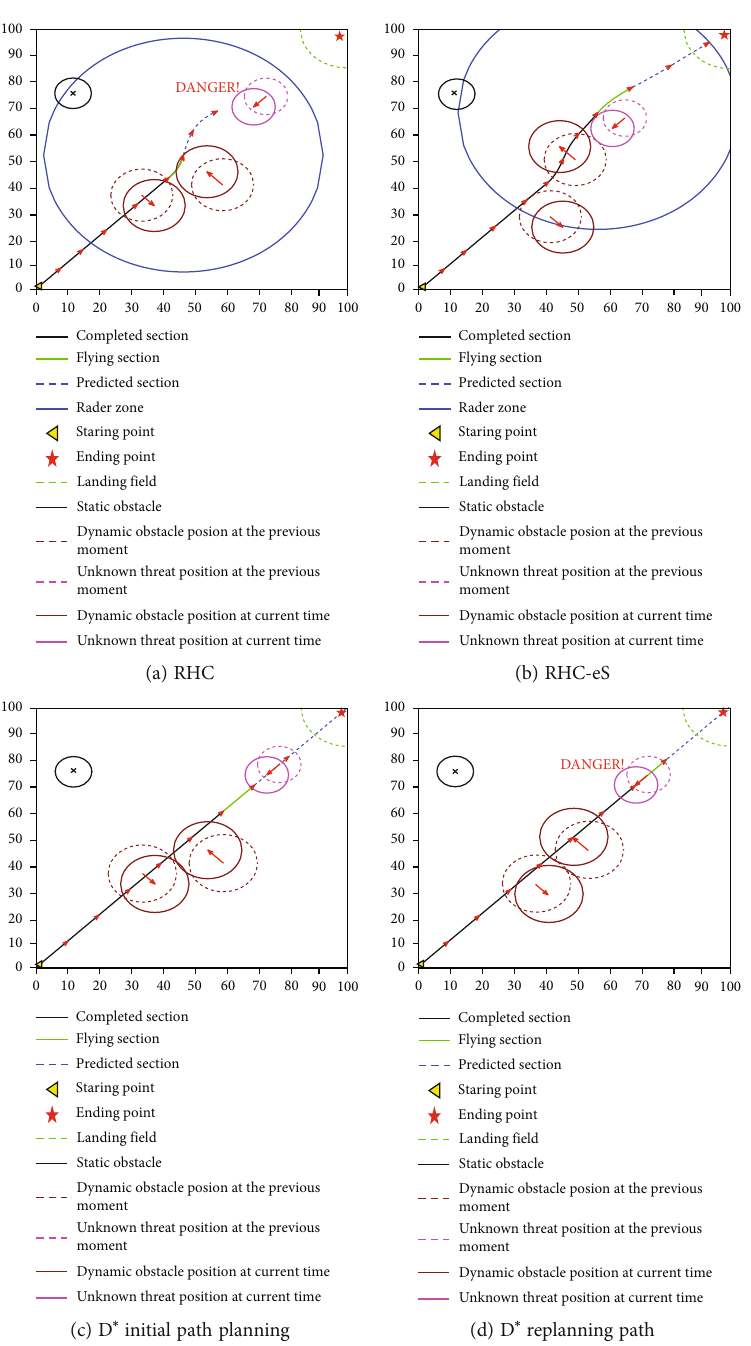
Figure 10: Environmental case 6 path planning